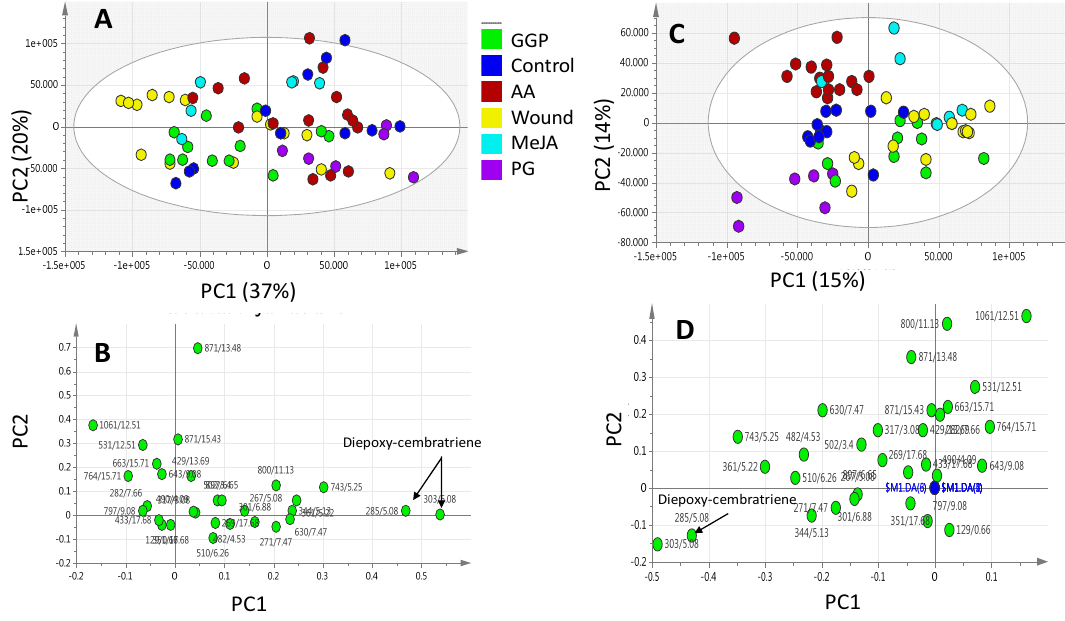
Figure 5. Principal component analysis (PCA) and orthogonal projection to latent structures-discriminant analysis (OPLS-DA) of UPLC-MS extracted metabolites from Lobophyton pauciflorum elicited with 20 and 200 μ M prostaglandin (PG), methyl jasmonate (MeJA), geranylgeranyl-pyrophosphate (GGP) and arachidonic acid (AA) in addition to wounding harvested at 0, 24 and 48 h post elicitation. ( A ) PCA score plot of PC1 vs. PC2 scores and its corresponding loading plot ( B ) showing contributing metabolites and their assignments. The clusters are located at the distinct positions in two-dimensional space described by two vectors of principal component 1 (PC1) = 37% and PC2 = 20%; ( C ) OPLS-DA score plot of PC1 vs. PC2 scores and its corresponding loading plot ( D ) showing contributing metabolites and their assignments. Selected variable masses are highlighted in the loading-plot with m/z /retention time (s) pair and identifications are discussed in text.